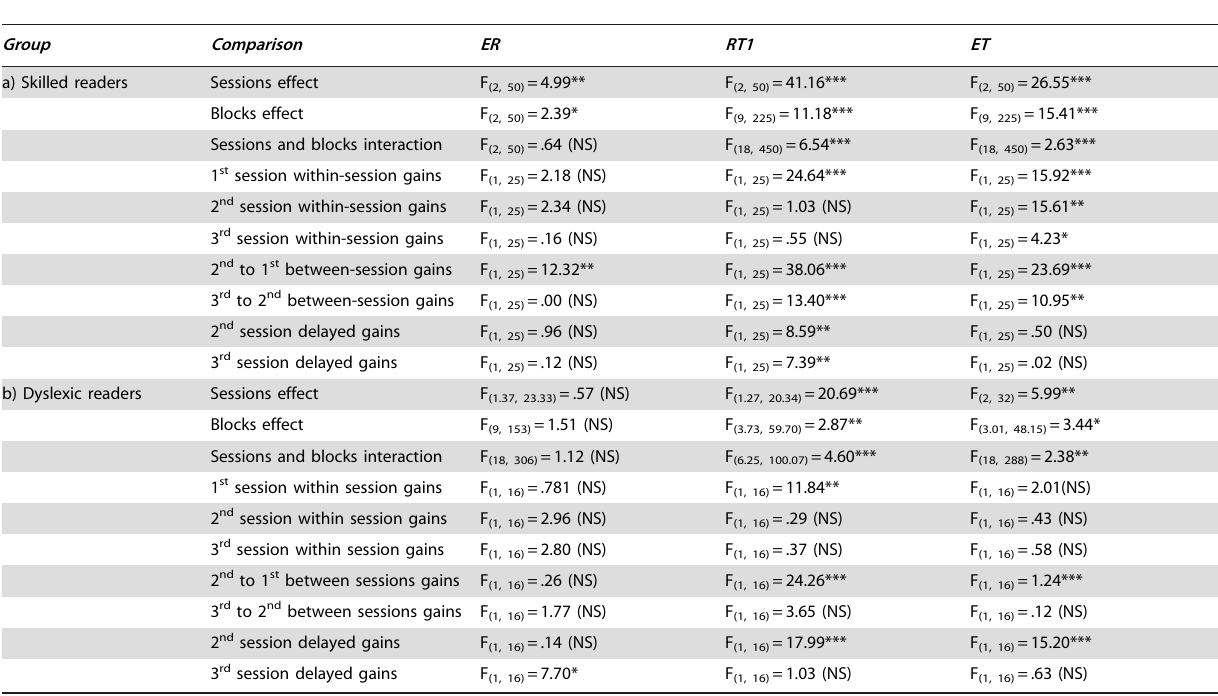
Table 2. ANOVA results for the volitional manual movement parameters for a) skilled and b) dyslexic readers.